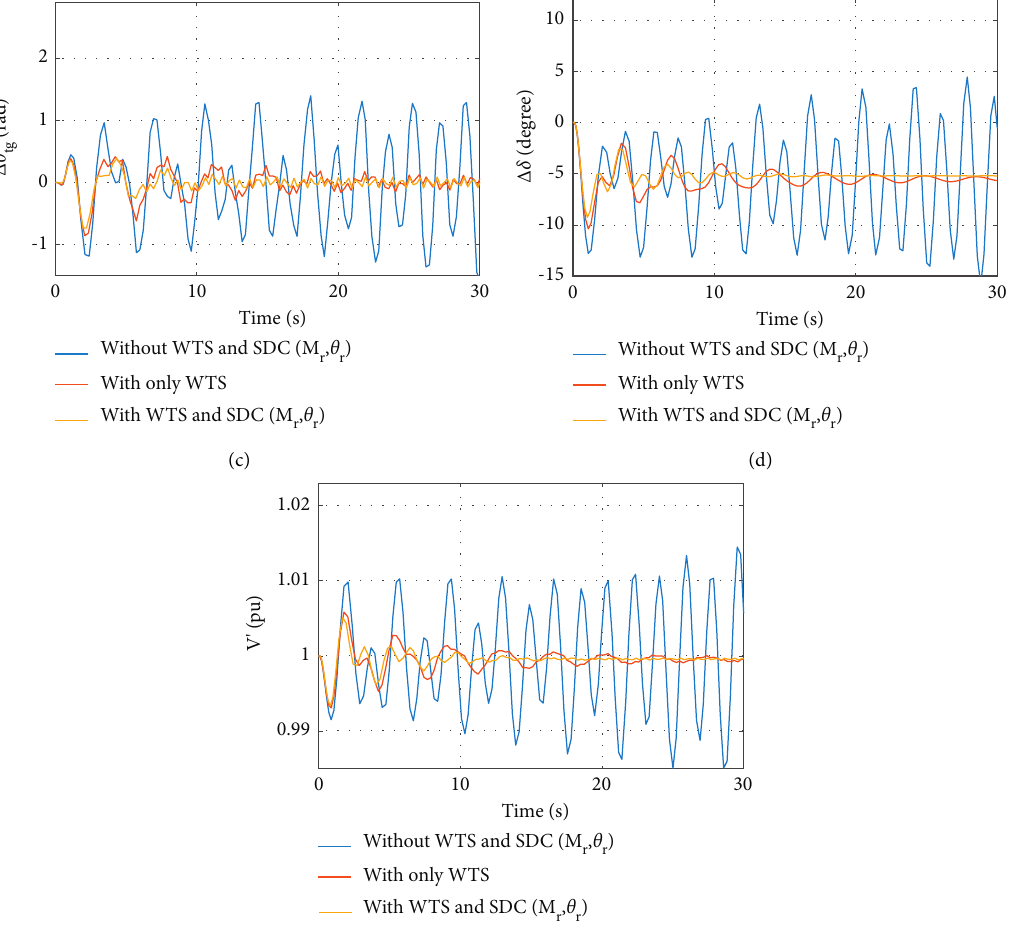
w ≈ 14m/s). (b) The rotor speed deviation in CPP (